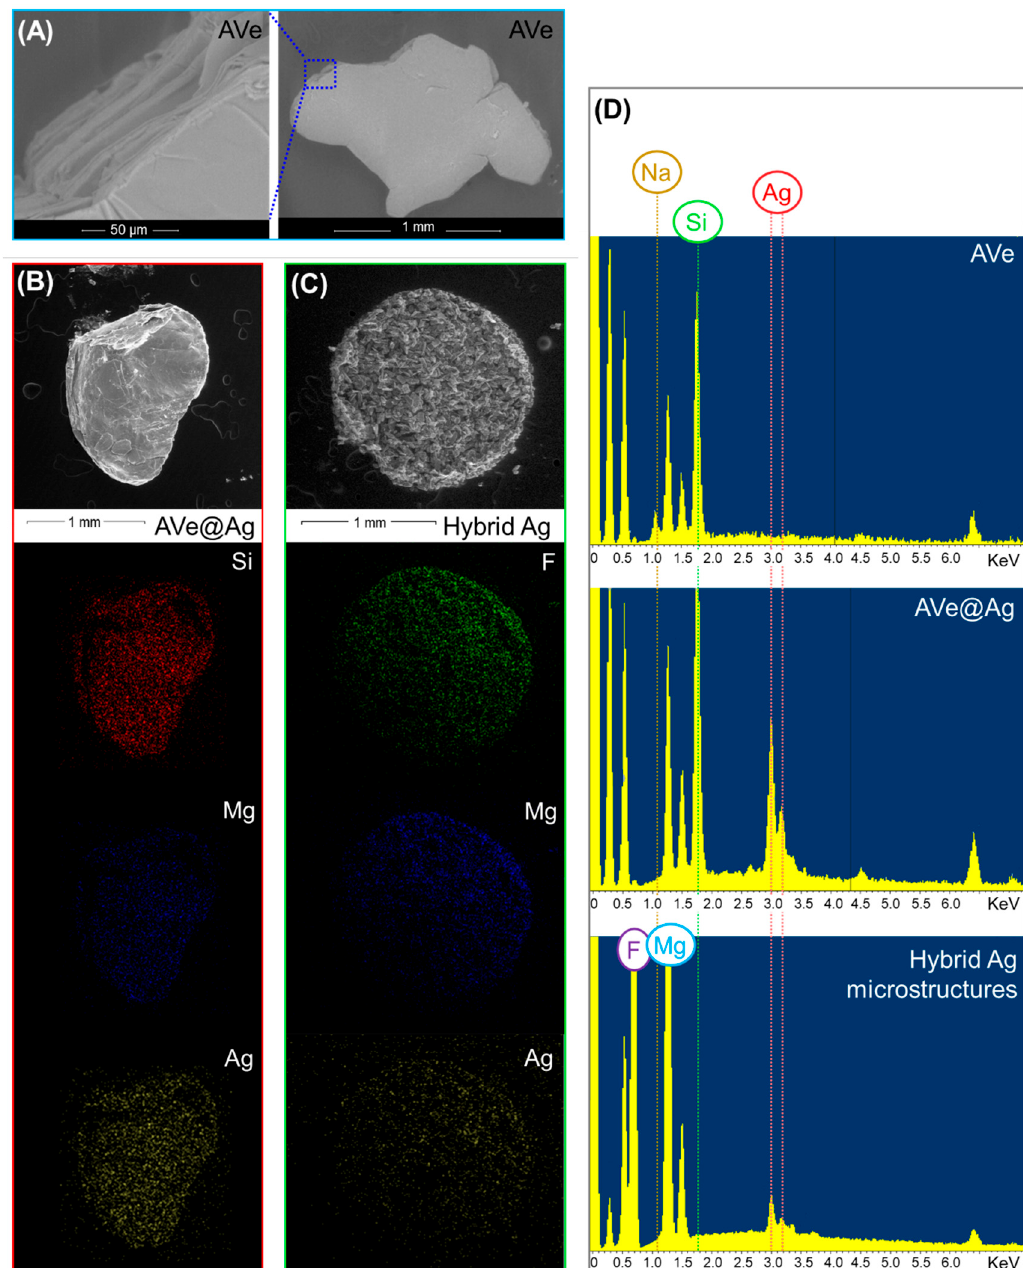
Figure 1. ( A–C ) Representative environmental scanning electron microscopy (ESEM) images of ( A ) activated vermiculite (AVe), ( B ) silver-coated activated vermiculite (AVe@Ag), and ( C ) hybrid Ag microstructures (from AVe). Elemental maps of ( B ) and ( C ) obtained via energy-dispersive X-ray (EDX) analysis are also shown. ( D ) EDX spectra of the illustrated structures.